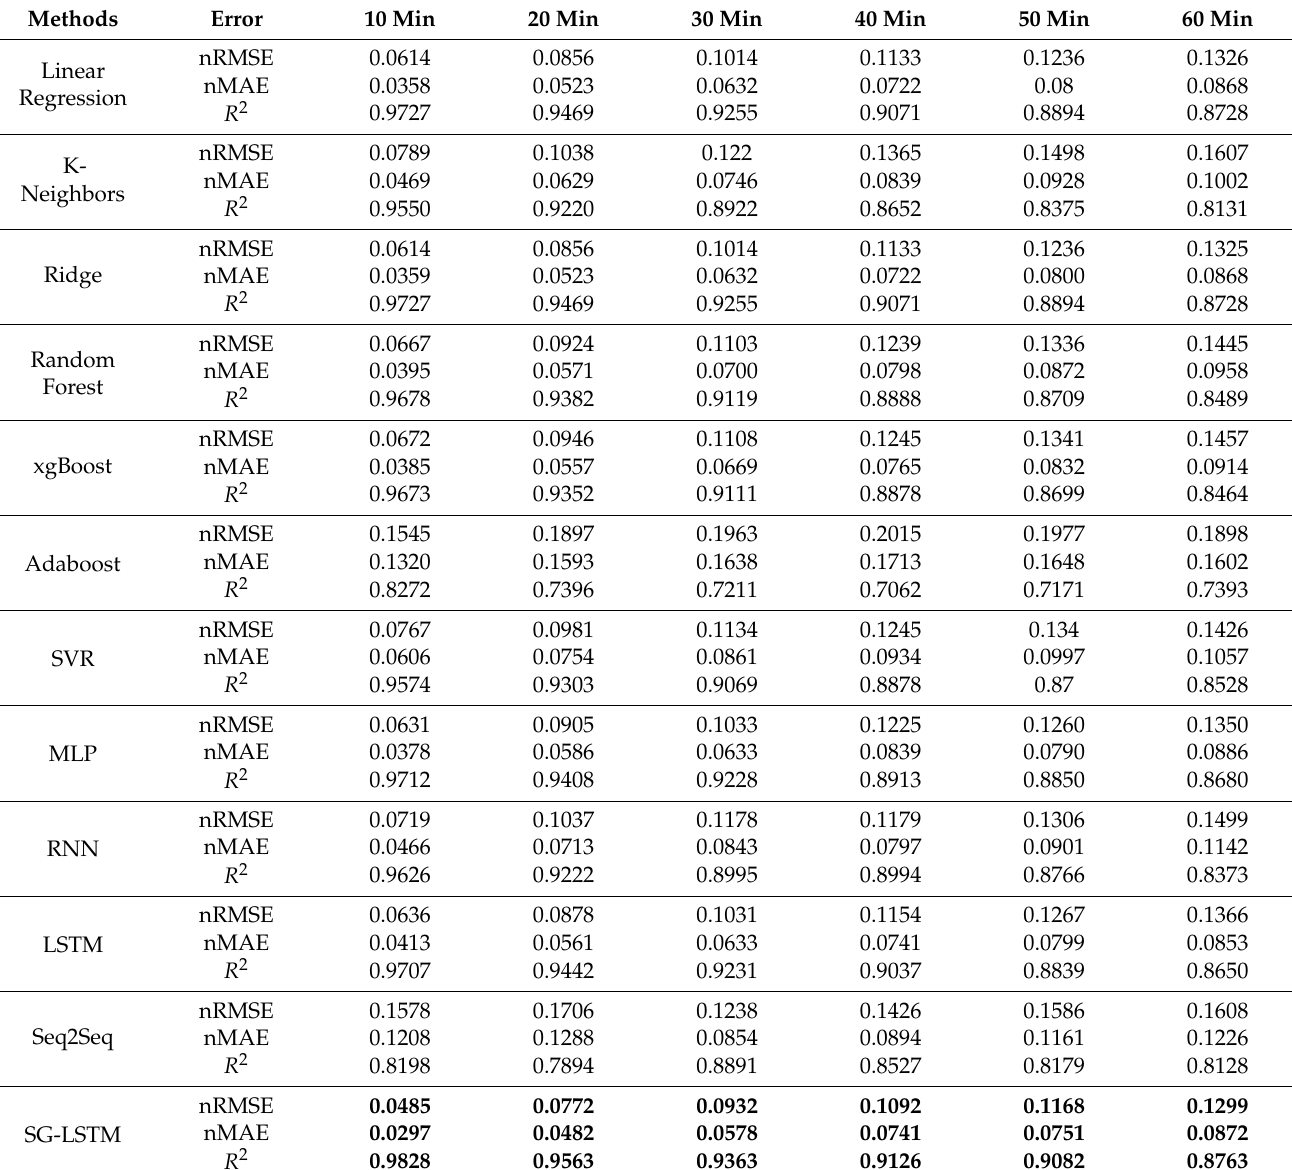
Table 4. Performance comparison of different models for forward multi-step power